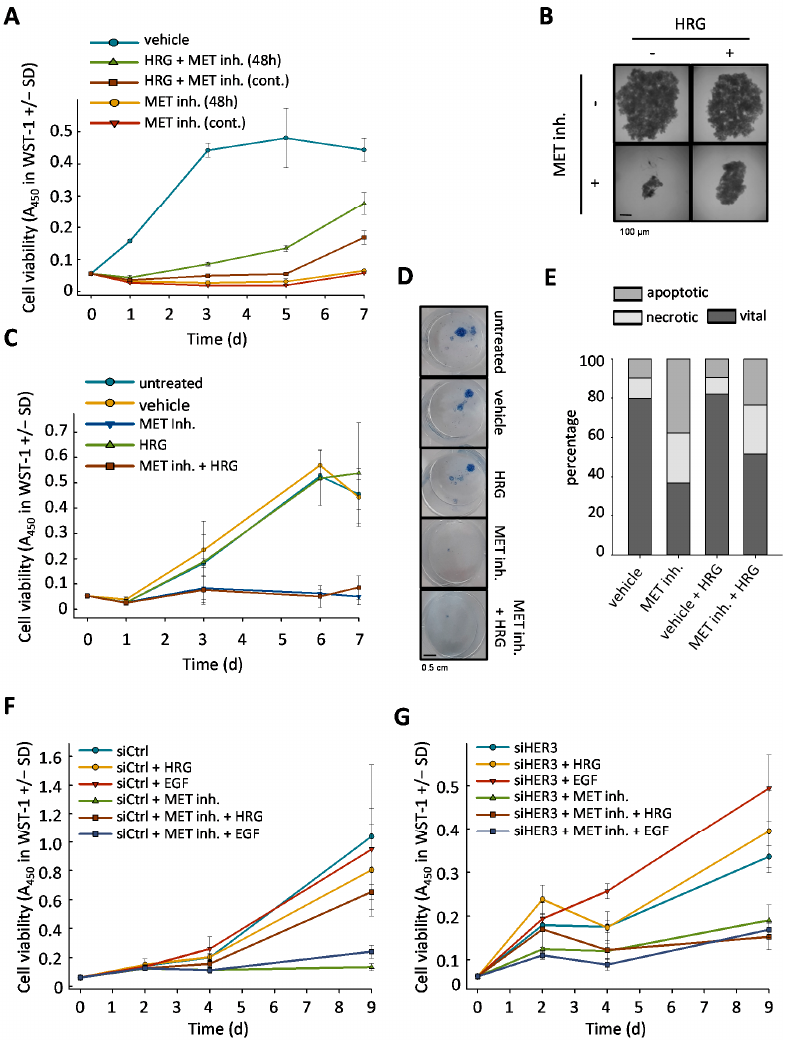
Figure 3. ( A ) In WST-1 assay, impaired MKN45 cell proliferation (vs. vehicle DMSO) upon MET inhibition is partially rescued by treatment with 20 ng/mL of heregulin (HRG); (cont.): continuous inhibitor (0.2 µM PF04217903) exposure, (48 h): removal of MET inhibitor after 48 h. ( B ) HRG (20 ng/mL) also partially reversed antiproliferative effects of MET inhibition in MKN45 cells on spheroid formation. In contrast, the severe effects upon MET inhibition could not be reversed by HRG in Hs746T cells as shown ( C ) in WST-1 assay or ( D ) spheroid outgrow formation; of note, these cells did not show compensatory HER3 upregulation upon MET inhibition, as has been shown in the previous Figure 2F. ( E ) Addition of HRG (20 ng/mL) also reduced the number of apoptotic cells in SNU5 cells treated with 0.2 µM PF04217903. HER3 displays the crucial factor mediating resistance against MET inhibition, as ( F ) the HER1 ligand EGF (50 ng/mL) could not reverse the antiproliferative effects of PF04217903 in contrast to HRG treatment, and ( G ) HER3 knockdown abrogated the HRG-induced rescue effects.